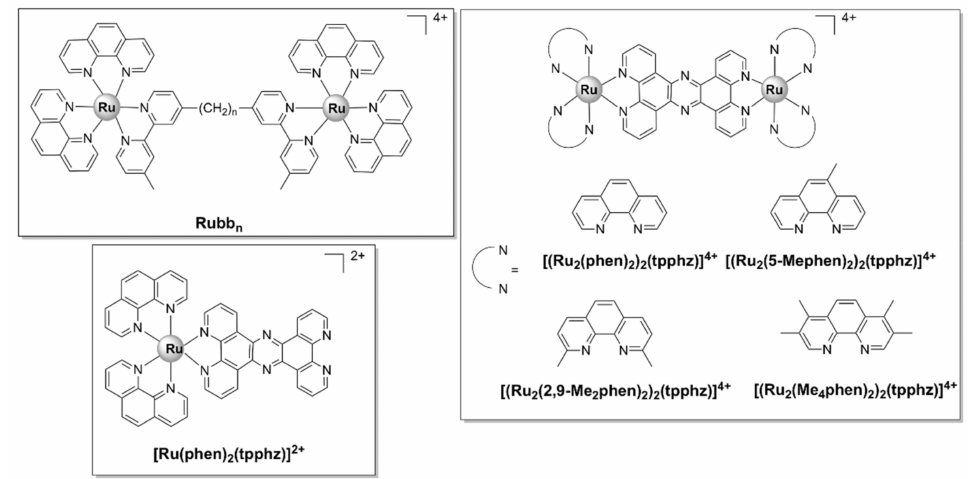
Figure 13. Chemical structures of the inert dinuclear Rubb n ([Ru 2 (phen) 2 (tpphz)] 4+ , [Ru 2 (5- Mephen) 2 (tpphz)] 4+ , [Ru 2 (2,9-Me 2 phen) 2 (tpphz)] 4+ , and [Ru 2 (Me 4 phen) 2 (tpphz)] 4+ ) and mononu- clear ([Ru(phen) 2 (tpphz)] 2+ )